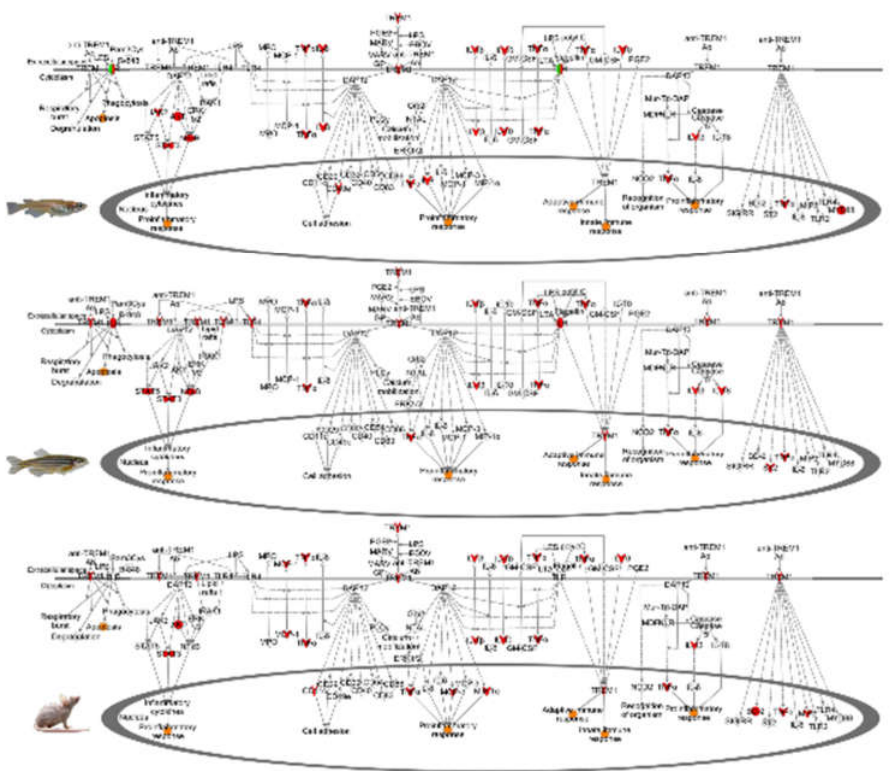
Figure 3. TREM1 modulation in medaka (top), zebrafish (middle), and mouse (bottom) show considerable overlap following FL exposure. All three vertebrates up-modulate key regulators, including TNF and IL1B . Red genes are up-modulated and green genes are down-modulated. Predicted down-stream functional effects that are expected to increase are in orange and to decrease are in blue.